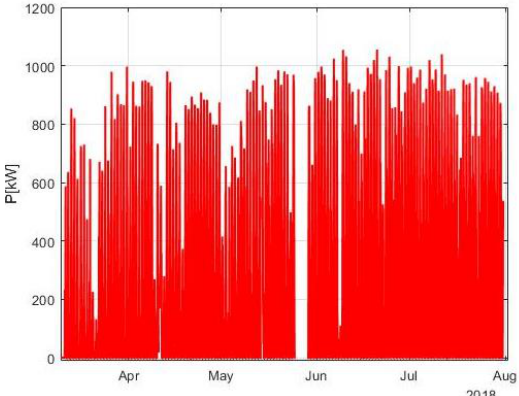
Figure 2. Power production